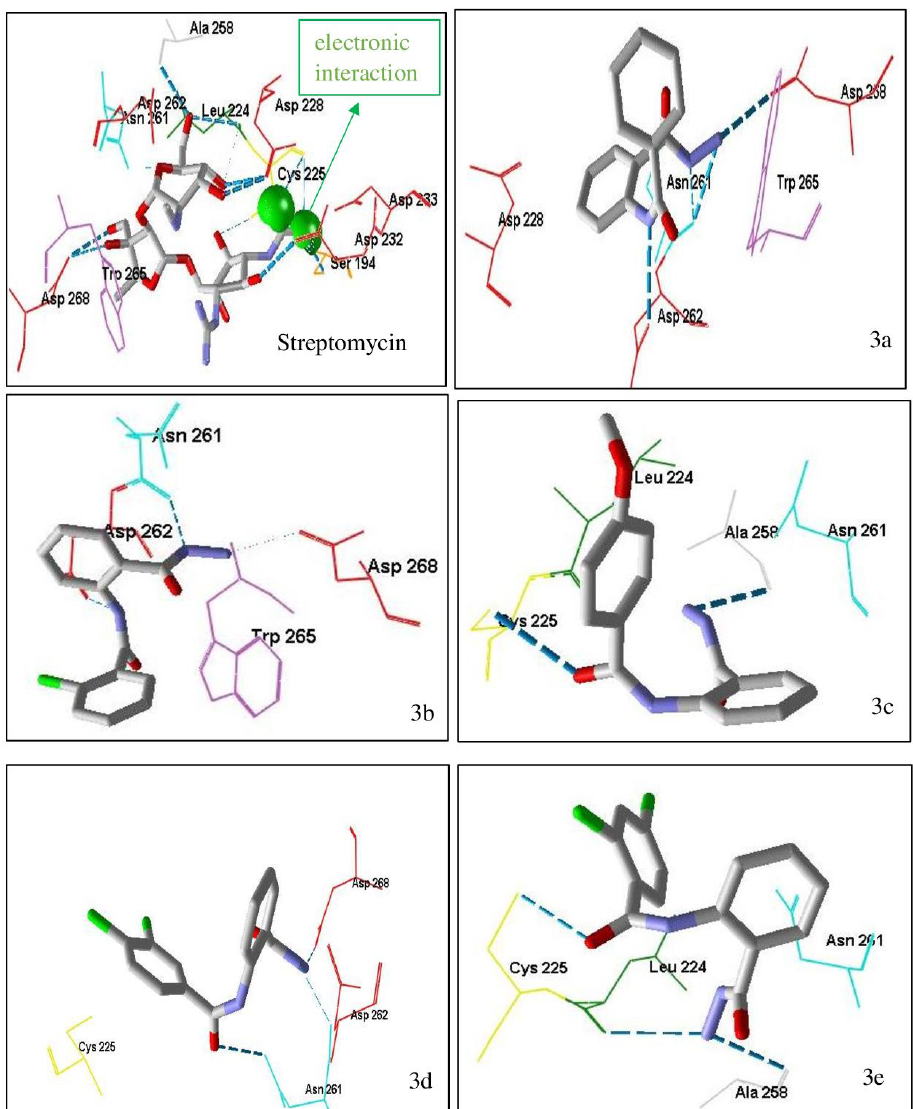
Figure 3. The molecular docking interaction between streptomycin and compounds 3a – e into active site in Aminoglycosid-2 ‘‘ -phosphotransferase-IIa enzyme abbreviated APH (2 ‘‘ ) -IIa methionyl- tRNA synthetase. Dashed line (blue color) is hydrogen bonding. The darker the blue color, the stronger hydrogen bonding and the closer the distance between the molecules. The details of color are as follows: yellow — cysteine (Cys); light blue — Asparagine (Asn); red — aspartic acid (Asp) ; dark green — leucine (Leu); dark pink — tryptophan (Trp); dark purple — tyrosine (Tyr); orange — serine (Ser); grey — alanine (Ala); white silver — glycine (Gly); dark blue — arginine (Arg); green — Isoleucine (Ile); peach — proline (Pro); light purple — histidine (His); light orange — threonine (Thr); sky blue — glutamine (Gln); maroon — glutamic acid (Glu); navy blue — lysine (Lys); light yellow — methionine (Met); magenta — phenylalanine (Phe); light green — valine (Val). Antifungal Docking Studies The grid box binding site was set X = 8.51 Å ; Y = 33.69 Å ; Z = − 25.99 Å with a cavity surrounded by 33 amino acids, namely Ile 12; Thr 13; Ile 30; Asp 32; Gly 34; Ser 35; Asp 37; Lys 50; Trp 51; Ile 82; Lys 83; Tyr 84; Gly 85; Asp 86; Ser 88; Lys 91; Arg 120; Ile 123; Gly 131; Glu 134; Lys 192; Lys 193; Asp 218; Gly 220; Thr 221; Thr 222; Ile 223; Tyr 225; Arg 297; Arg 299; Asp 303; Ile 305; Lys 323. The result of redocking validation process with